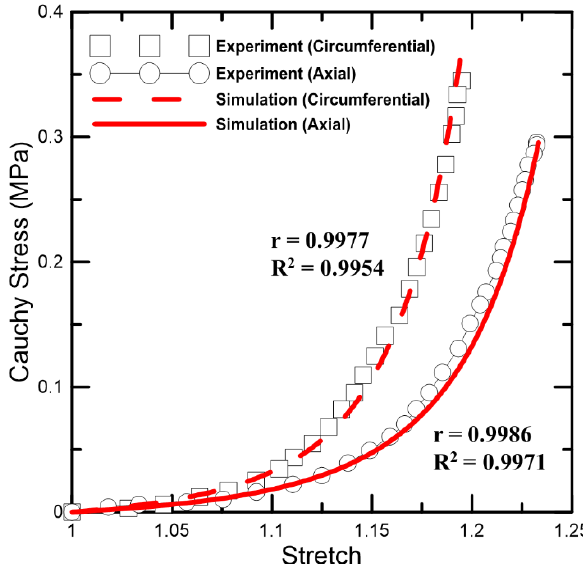
Figure 5. Stress – stretch curve of the arterial tissue determined during tensile tests and simulation.